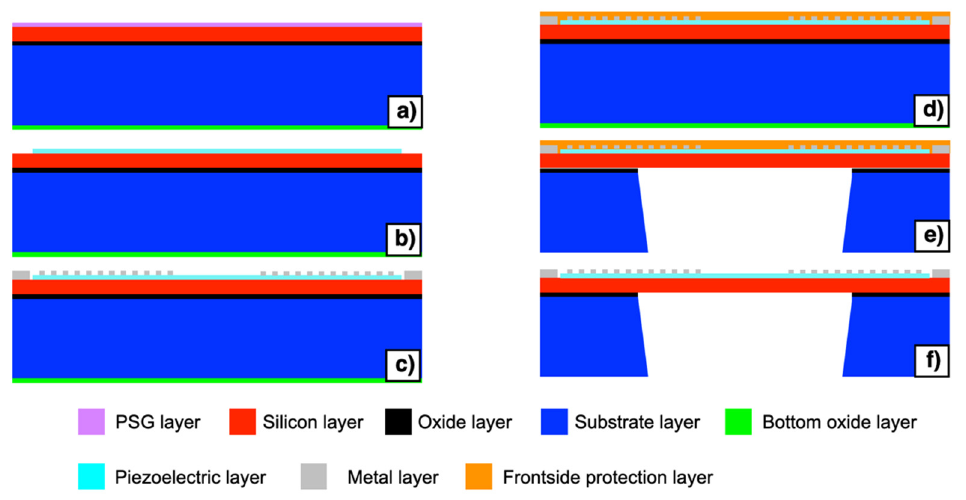
Figure 2. Manufacturing process steps ( a )–( f ) of the piezoelectric multi-user MEMS processes (PiezoMUMPs) technology involved for the fabrication of the piezoelectric MEMS device.